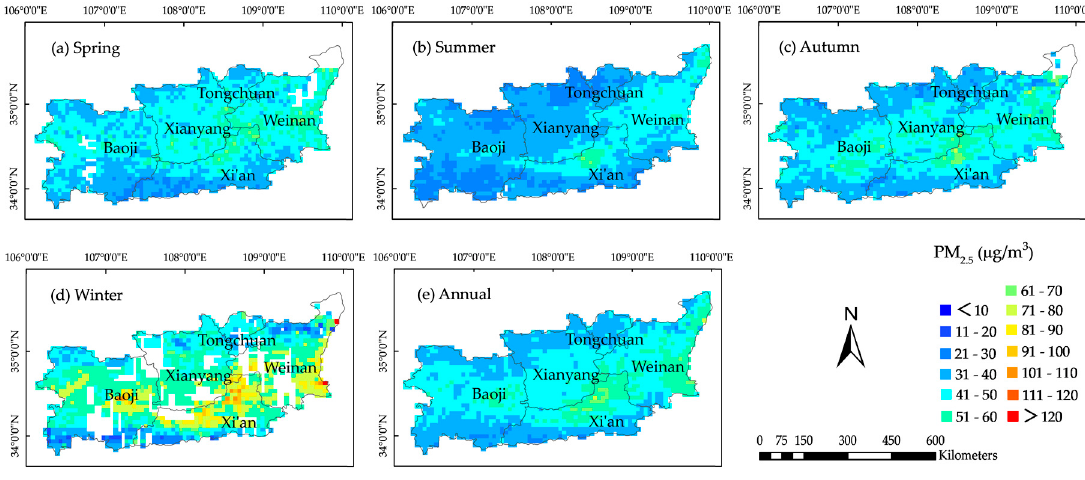
Figure 8. Same as Figure 7, but predicted by the GWR model.